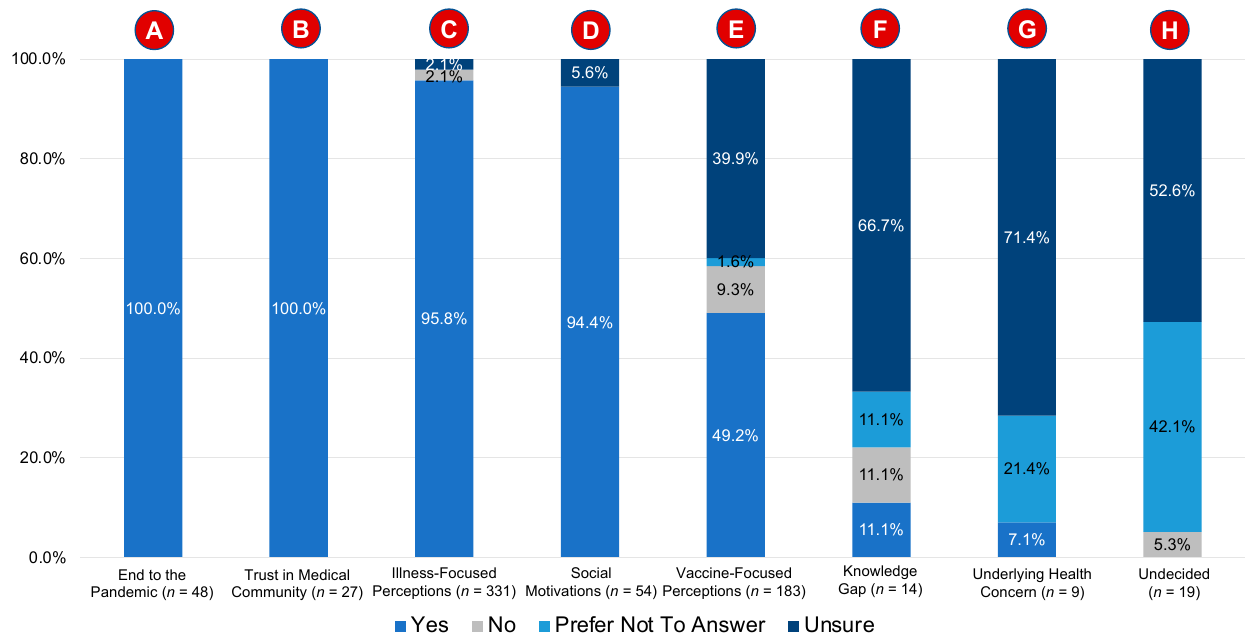
Figure 2. Proportion of individuals in each of the eight domains who responded “yes”, “no”, “prefer not to answer”, or “unsure” to the statement “I plan to obtain the COVID-19 vaccine when it is available”.